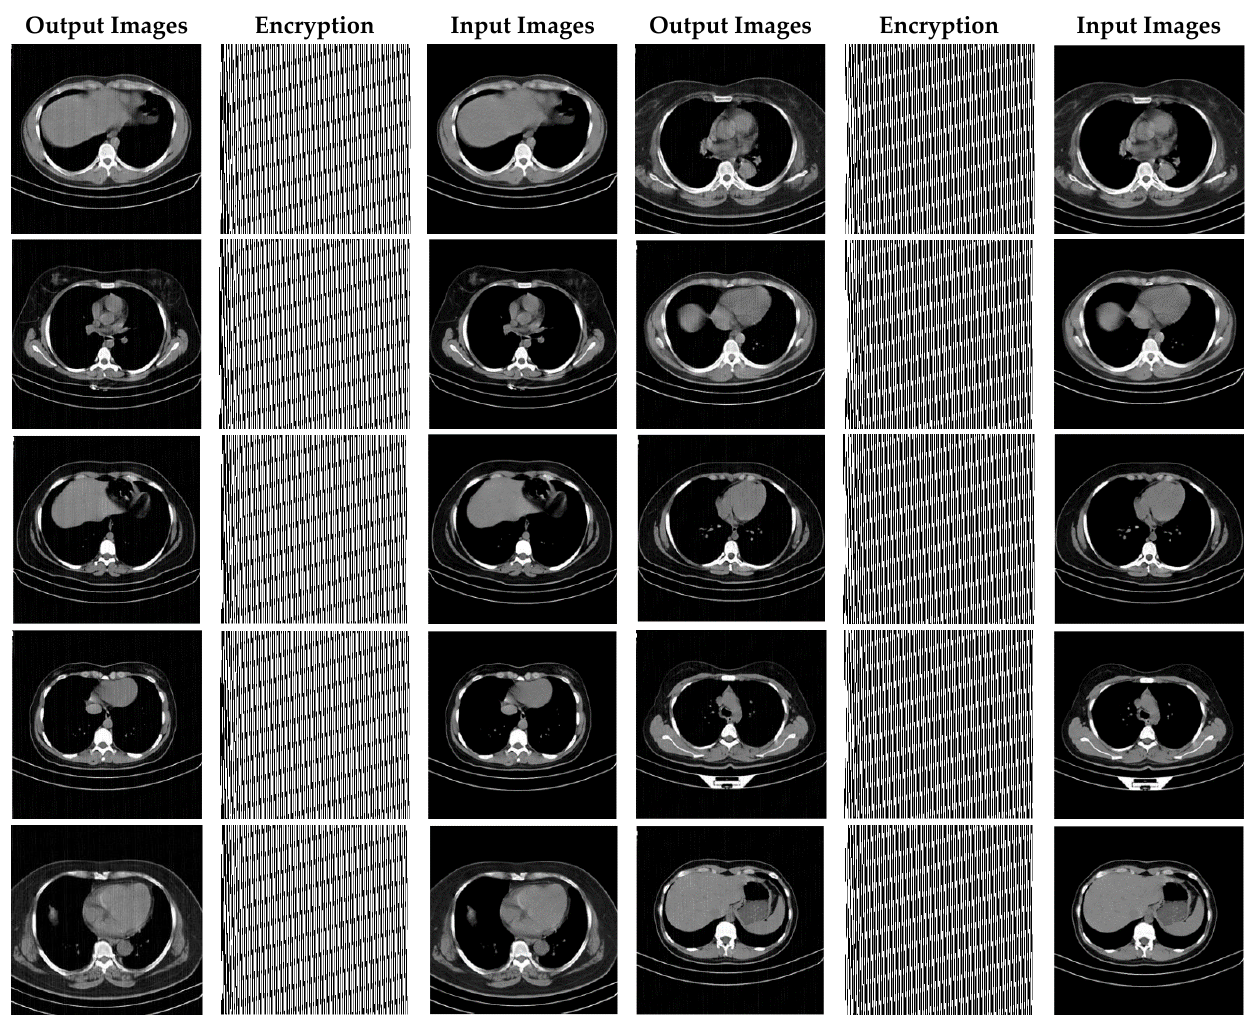
Figure 16. CT images encrypted using the proposed method.